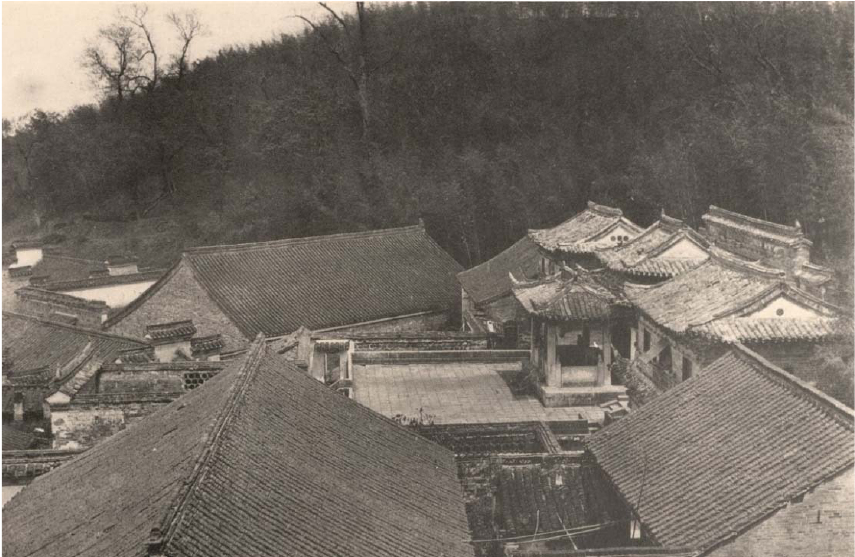
Figure 4. Photograph of the Open-Air Platform, with the Surrounding Buildings (Prip-Møller 1937, p. 249, Figure 275).